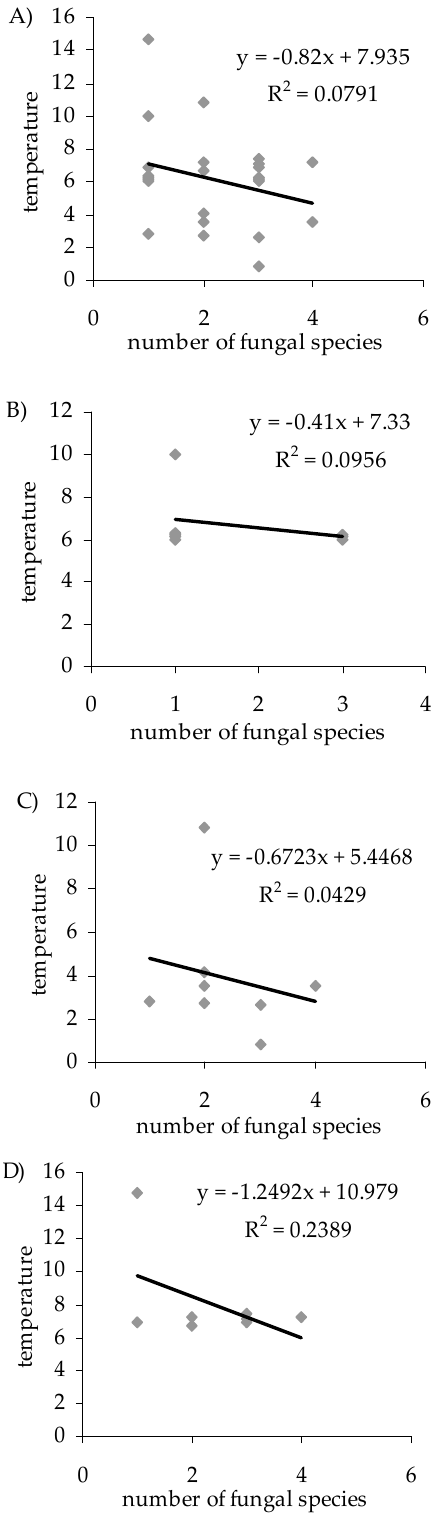
Figure 4. Relationship between the number of keratinophilic and keratinolytic fungal species and the soil/sediment temperatures (°C) in all the caves ( A ) ( p < 0.05; r = –0.30); the Brestovská Cave ( B ) ( p < 0.05; r = − 0.31); the Demänovská Ľ adová Cave ( C ) ( p < 0.05; r = − 0.21); and the Demänovská Slobody Cave ( D ) ( p < 0.05; r = − 0.54).